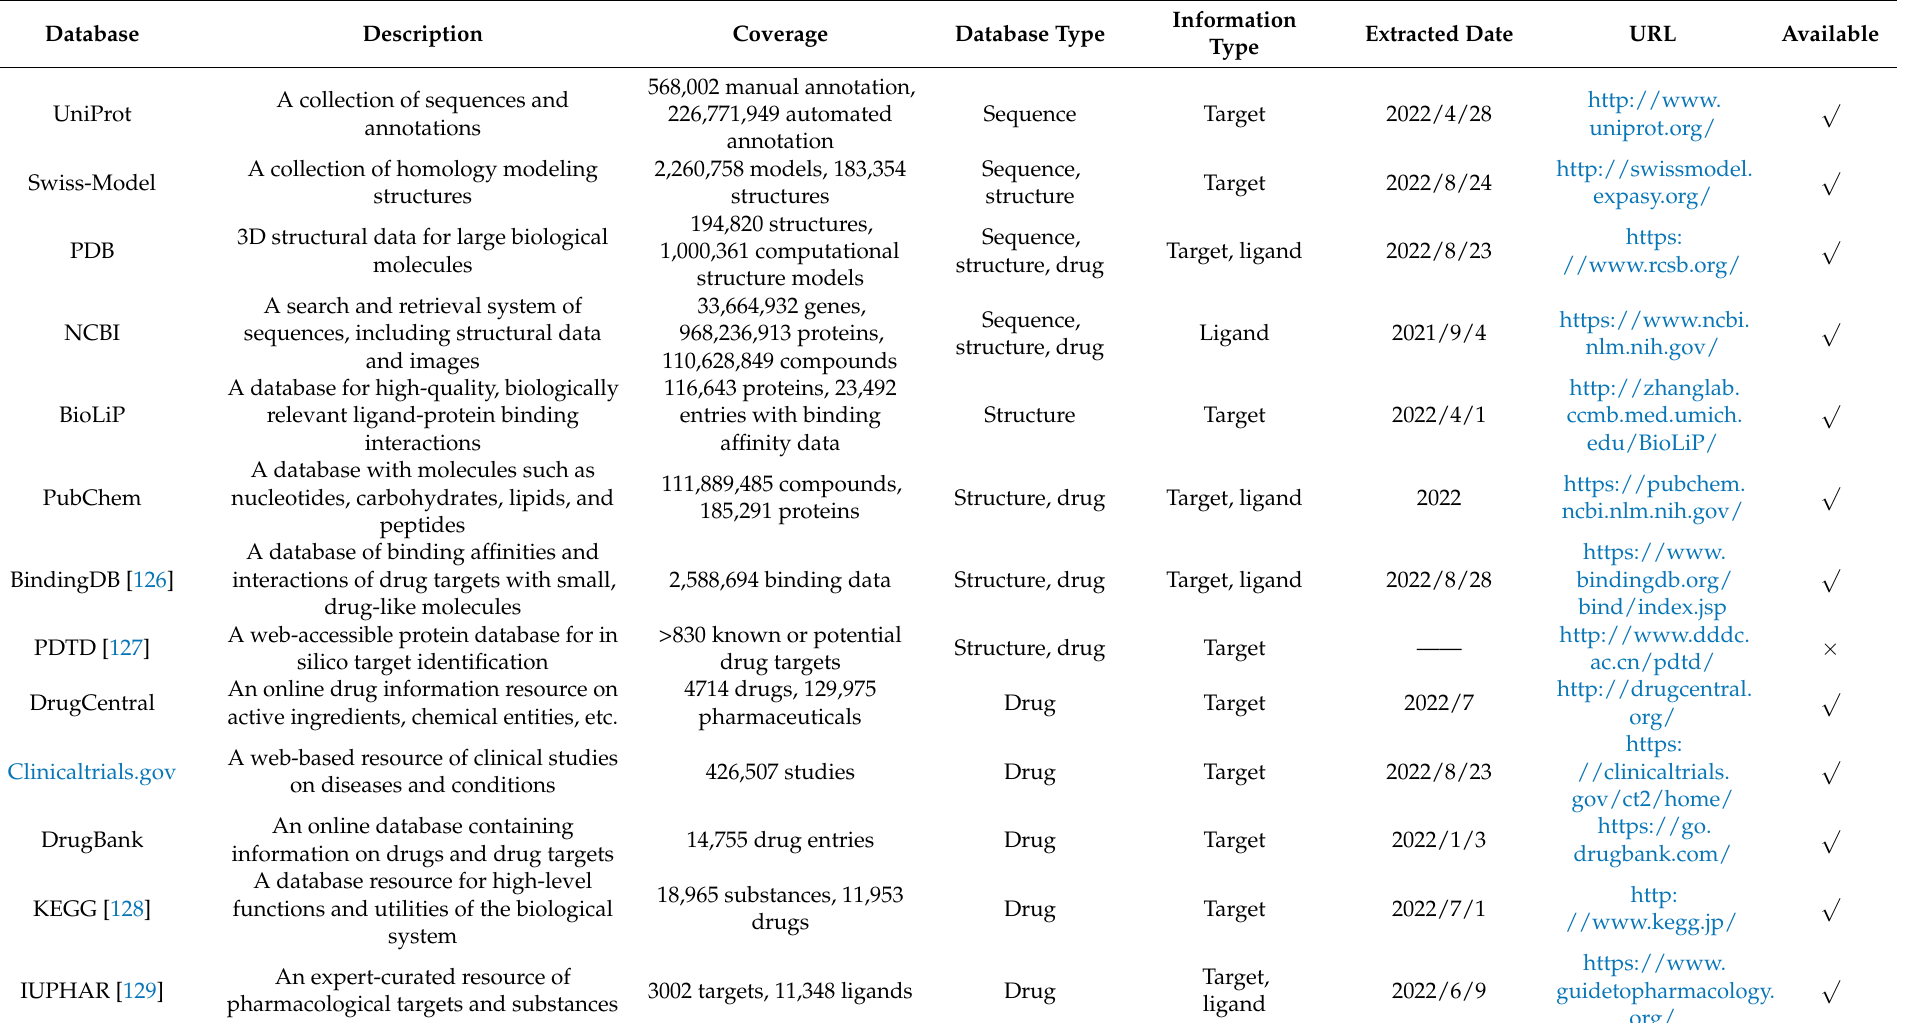
Table 4. Resource databases for searching binding sites and druggable